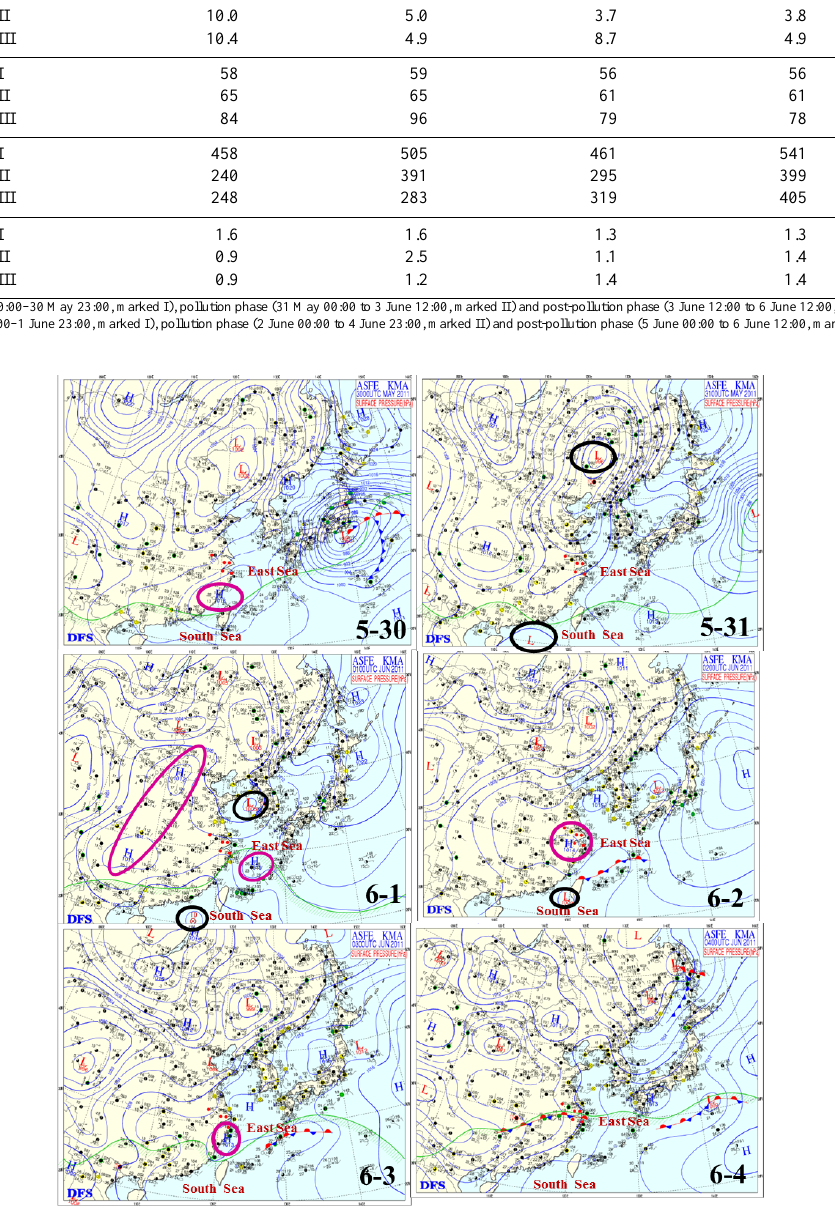
Fig. 4. Surface weather patterns over eastern China from 30 May to 4 June 2011. Black circle represents the low pressure center, pink circle represents the high pressure center, and red dot denotes the sampling site.